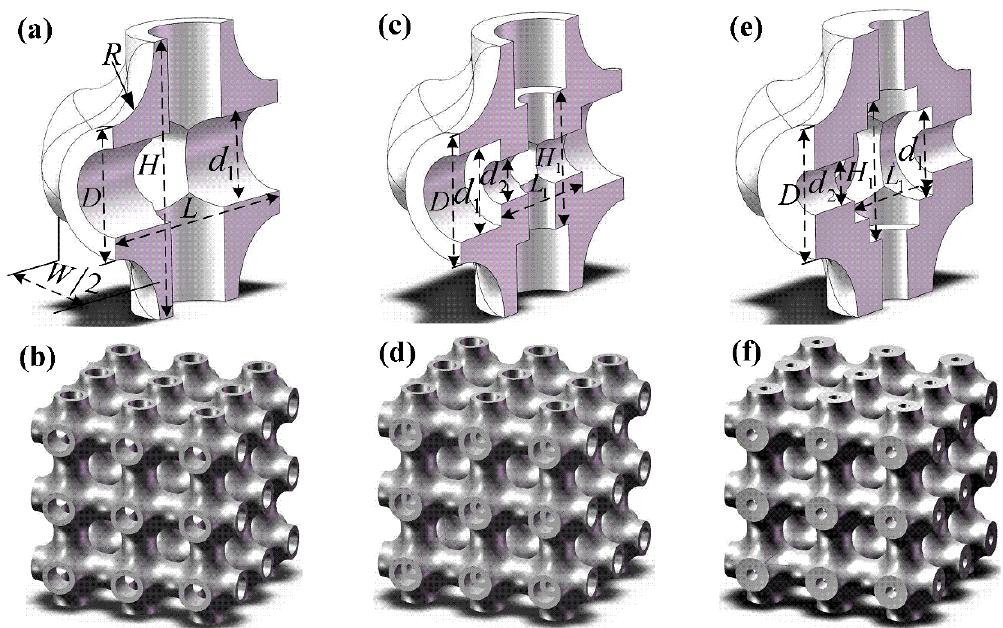
Figure 1. Semi-cellular models and corresponding design specimens: ( a ) semi-cellular model of hollow truss, ( b ) basic hollow truss structure (specimen HT), ( c ) semi-cellular model with tubular microstructures at joint, ( d ) hollow truss structure with internal microstructures at joints (specimen HTSJ), ( e ) semi-cellular model with tubular microstructures on tube walls, and ( f ) hollow truss structure with internal microstructures on tube walls (specimen HTSW).